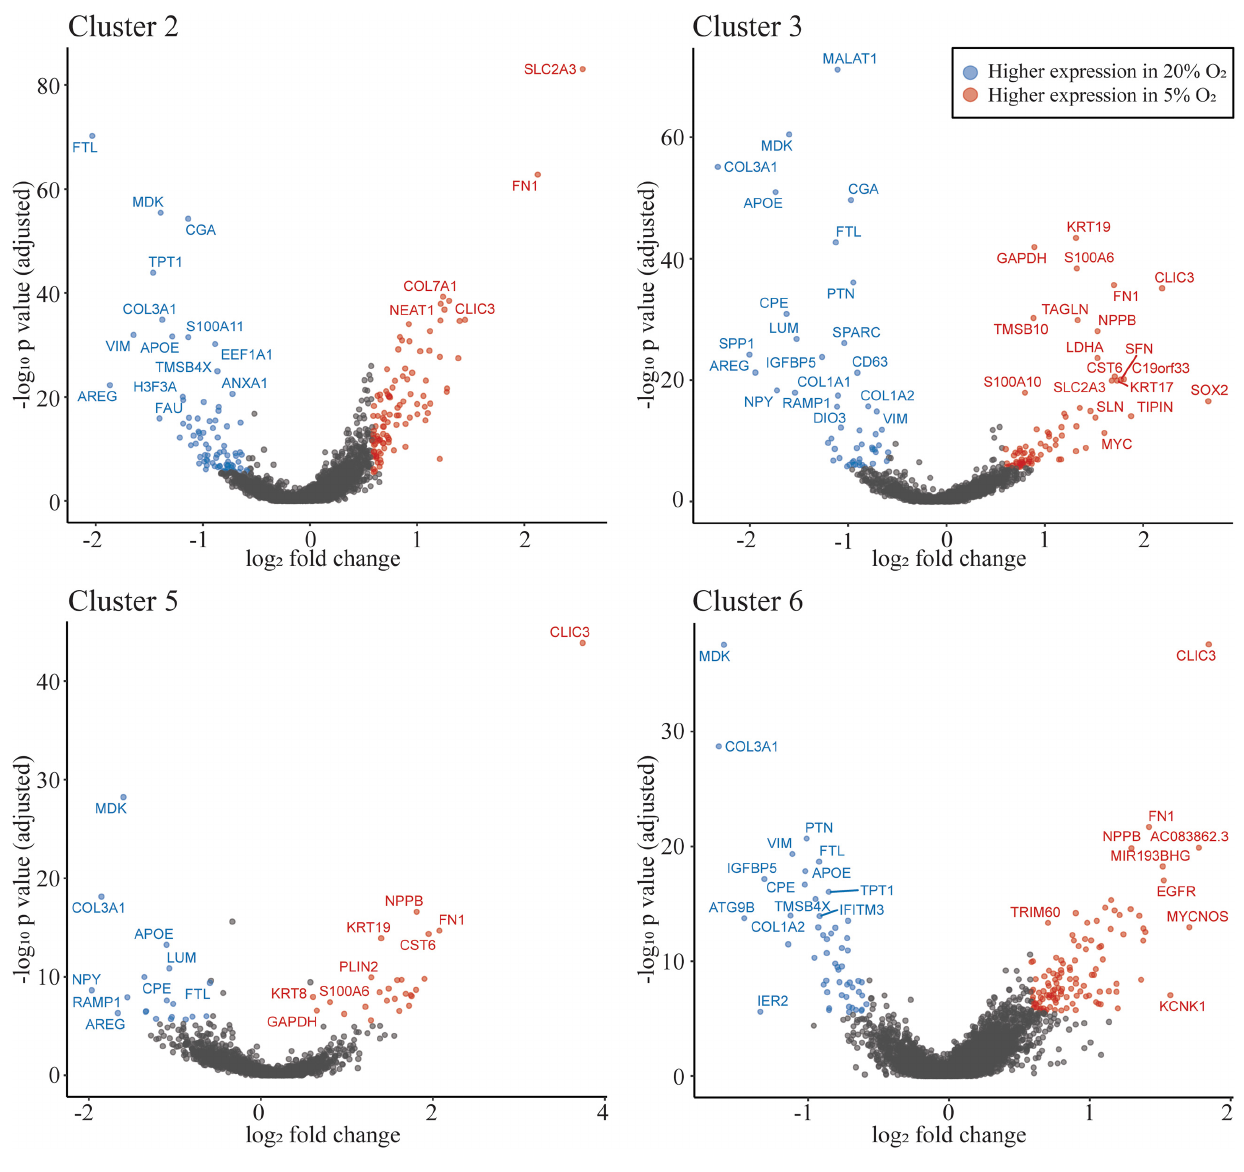
FIGURE 5 | Oxygen concentration influences gene expression profiles. Volcano plot showing differentially expressed genes in clusters 2, 3 (most similar to extravillousTB), 5 and 6 (most similar to syncytioTB). The highlighted dots show genes with an absolute fold change ≥ 1.5, with an adjusted p-value of ≤ 0.05. The genes shown as dots in blue have higher expression in 20% O 2 and red dots have higher expression in 5% O 2